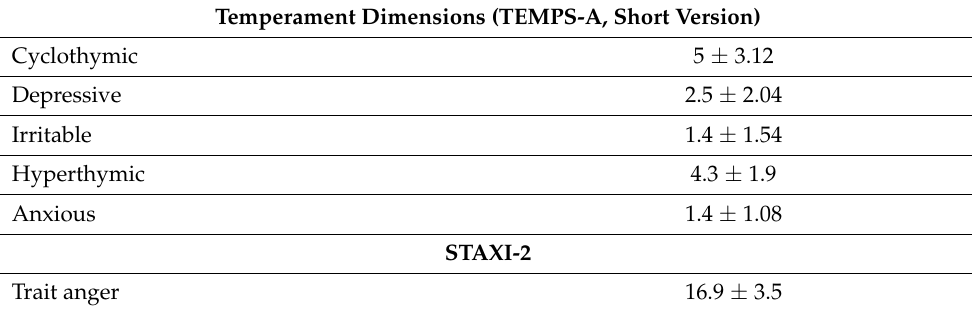
Table 2. Descriptive statistics of the psychological study variables (mean ± SD).